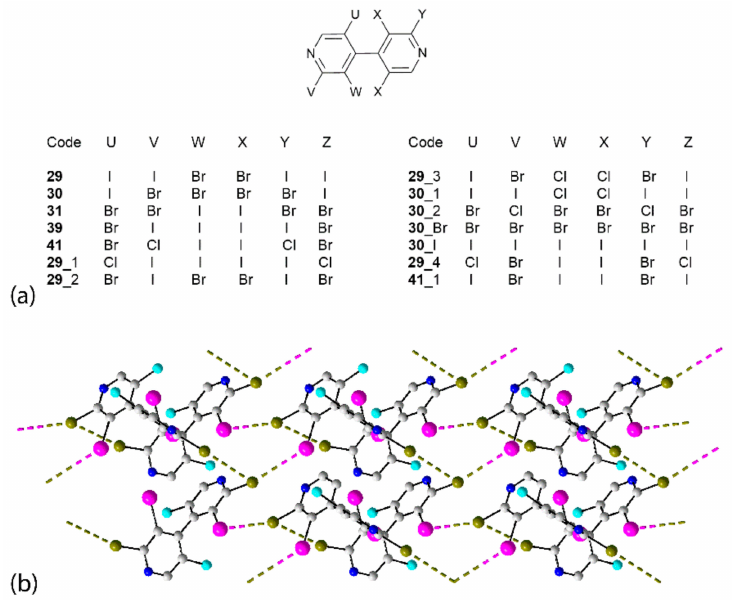
Figure 15. ( a ) Chemical diagrams for the congeners of 29 and ( b ) a view of the two-dimensional array in the crystal of 29 _4 (d(Br · · · Br) = 3.565(2) Å; C–Br · · · Br = 165.29(11) ◦ and C–Br · · · Br = 73.51(11) ◦ ) and (d(I · · · Br) = 3.749(2) Å; C–I · · · Br = 125.61(10) ◦ and C–Br · · · I = 157.27(11) ◦